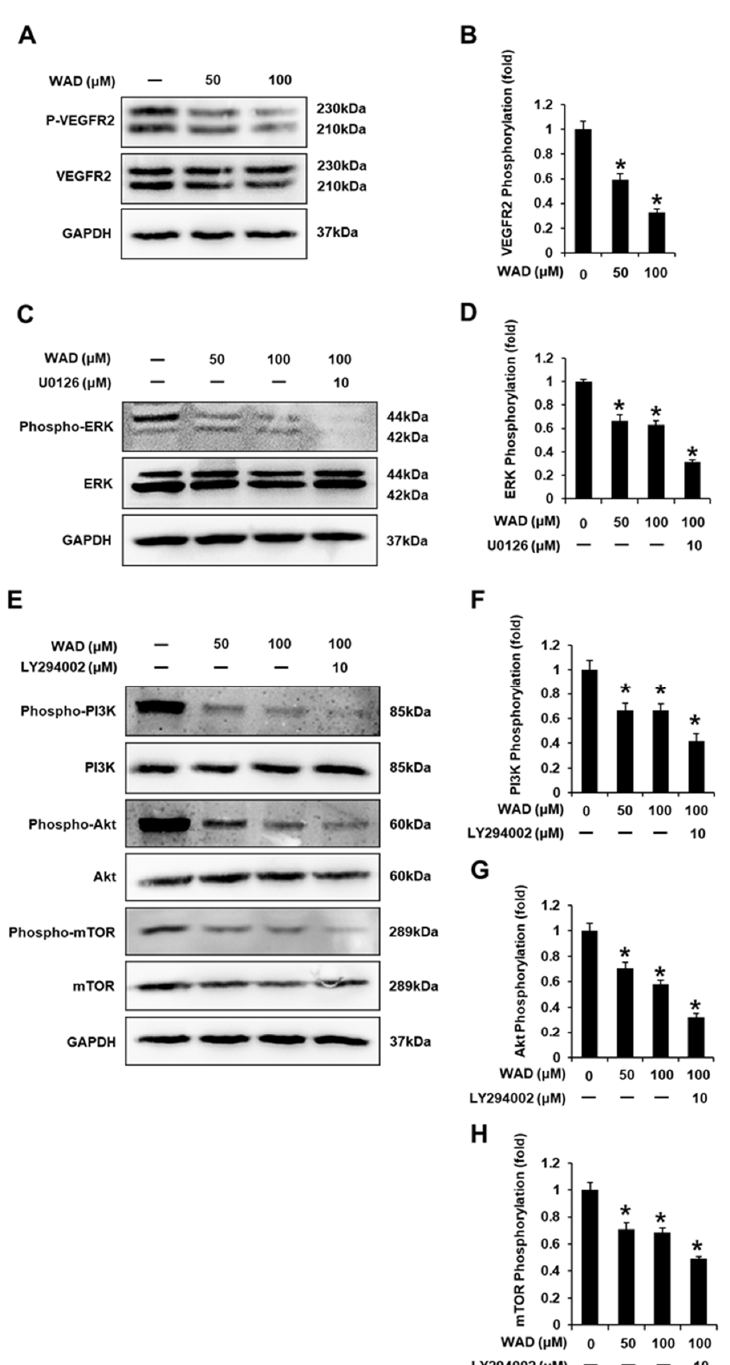
Figure 10. Effects of withagenin A diglucoside (WAD) on the vascular endothelial growth factor receptor 2 (VEGFR2) signaling pathway in human umbilical vein endothelial cells (HUVECs). HUVECs were treated with WAD (50 and 100 μ M), U0126 (10 μ M), and/or LY294002 (10 μ M) for 24 h. Cells were treated with culture media containing 0.5% DMSO as vehicle controls. Protein expression levels of ( A , B ) phospho-VEGFR2), VEGFR2, ( C , D ) phospho-extracellular signal-regulated kinase (Phospho-ERK), ERK, ( E – H ) phospho-phosphoinositide 3-kinase (Phospho-PI3K), PI3K, phospho-Akt, Akt, phospho-mammalian target of rapamycin (Phospho-mTOR), mTOR, and glyceraldehyde-3-phosphate dehydrogenase (GAPDH). Each bar graph presents the densitometric quantification of protein ex- pression levels. Data are presented as the mean ± standard error of the mean (SEM). n = 3, * p < 0.05 compared with the